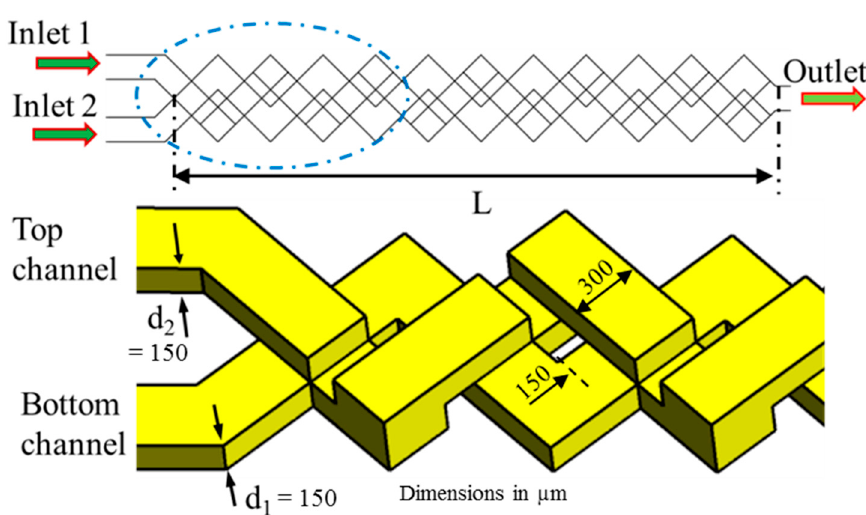
Figure 8. Barrier embedded chaotic micromixer: M ‐ 8 (no. of mixing units used: 6) [58].